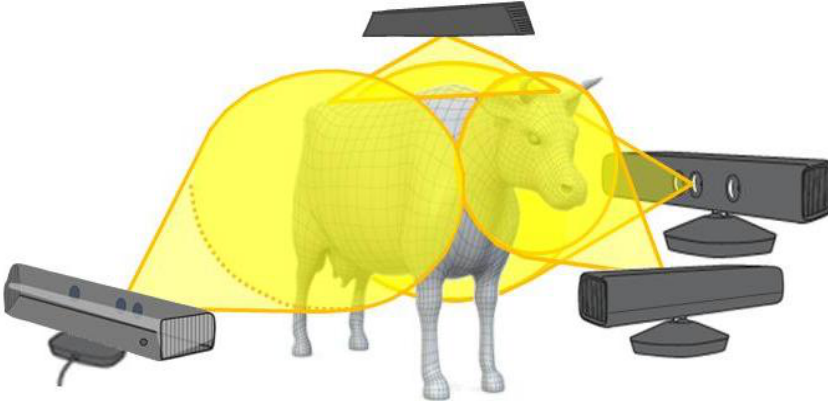
Figure 1. Perspective view of the animal, with relative positions of the three-dimensional (3D) optical sensors.